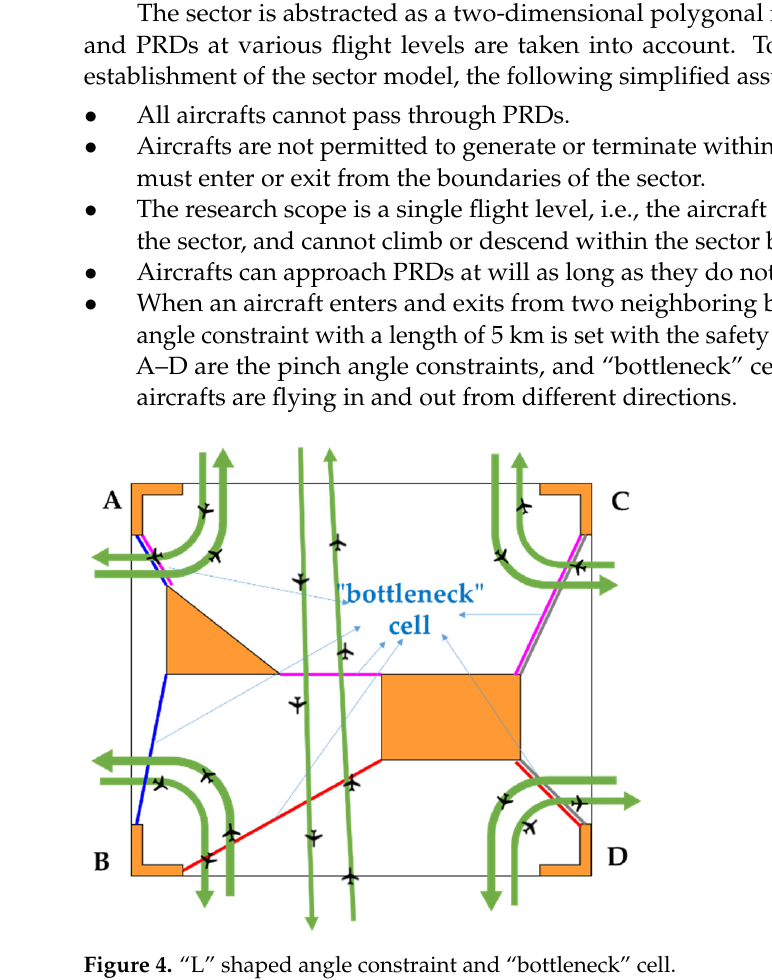
Figure 5. A shortest B – T path defines the capacity of the min-cut in the polygonal sector. The above 2D polygonal sector is abstracted into a network, which is defined as the FSRAN, as shown in Figure 6. A pair of vertices in the FSRAN are connected by an edge whose length is equal to the minimum (Euclidean) distance between the PRDs that corre- spond to the vertices. Then, the shortest path problem between T and B is resolved using Dijkstra’s algorithm. The min-cut made in the polygonal sector by the traffic flow is the